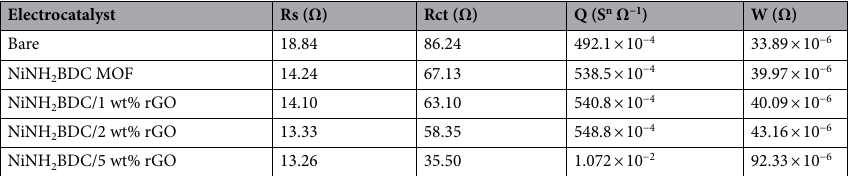
Table 2. CPE (Q), Warburg diffusion coefficient (W), charge transfer resistance (Rct), and resistance of solution (Rs) of NiNH